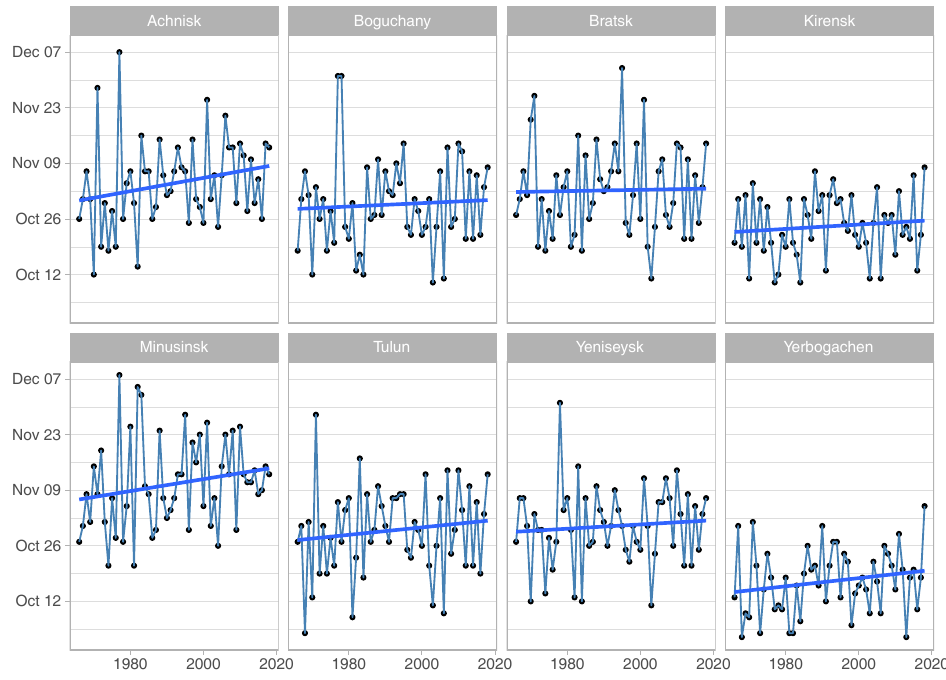
Figure 5. Annual shifts of season start